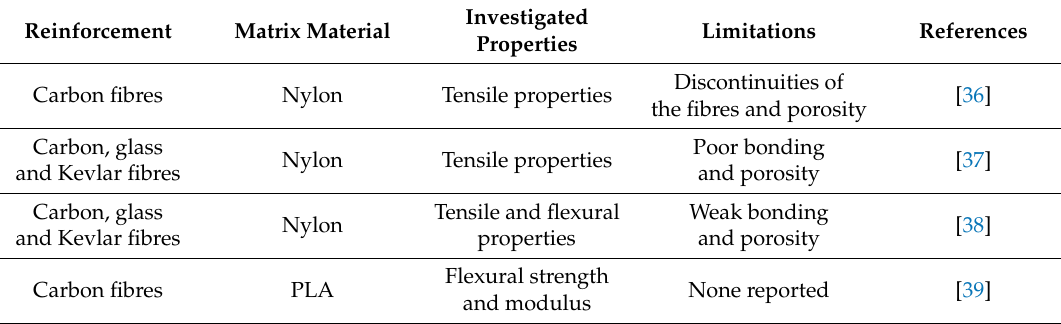
Table 2. A summary of some studies on FFF with continuous